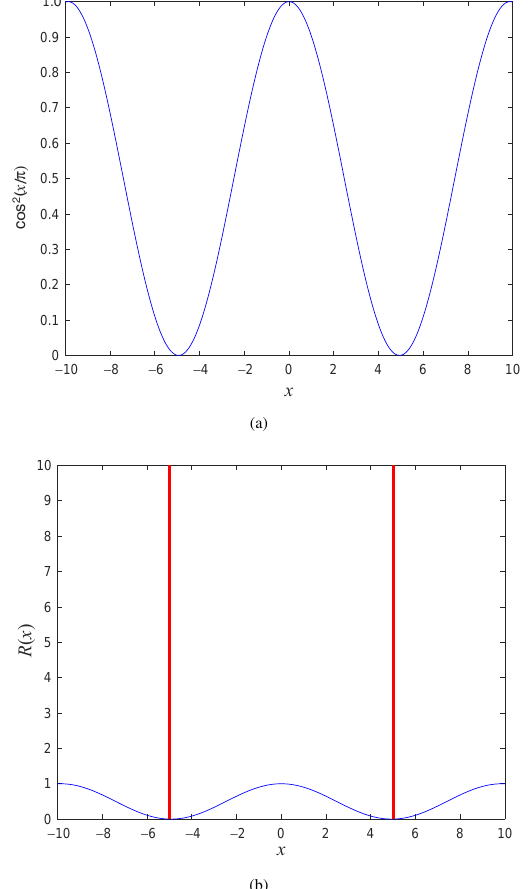
Fig. 2 Illustration of the repulsion technique. (a) Original NEs problem with two roots and (b) neighborhood around the found roots is penalized according to the repulsion